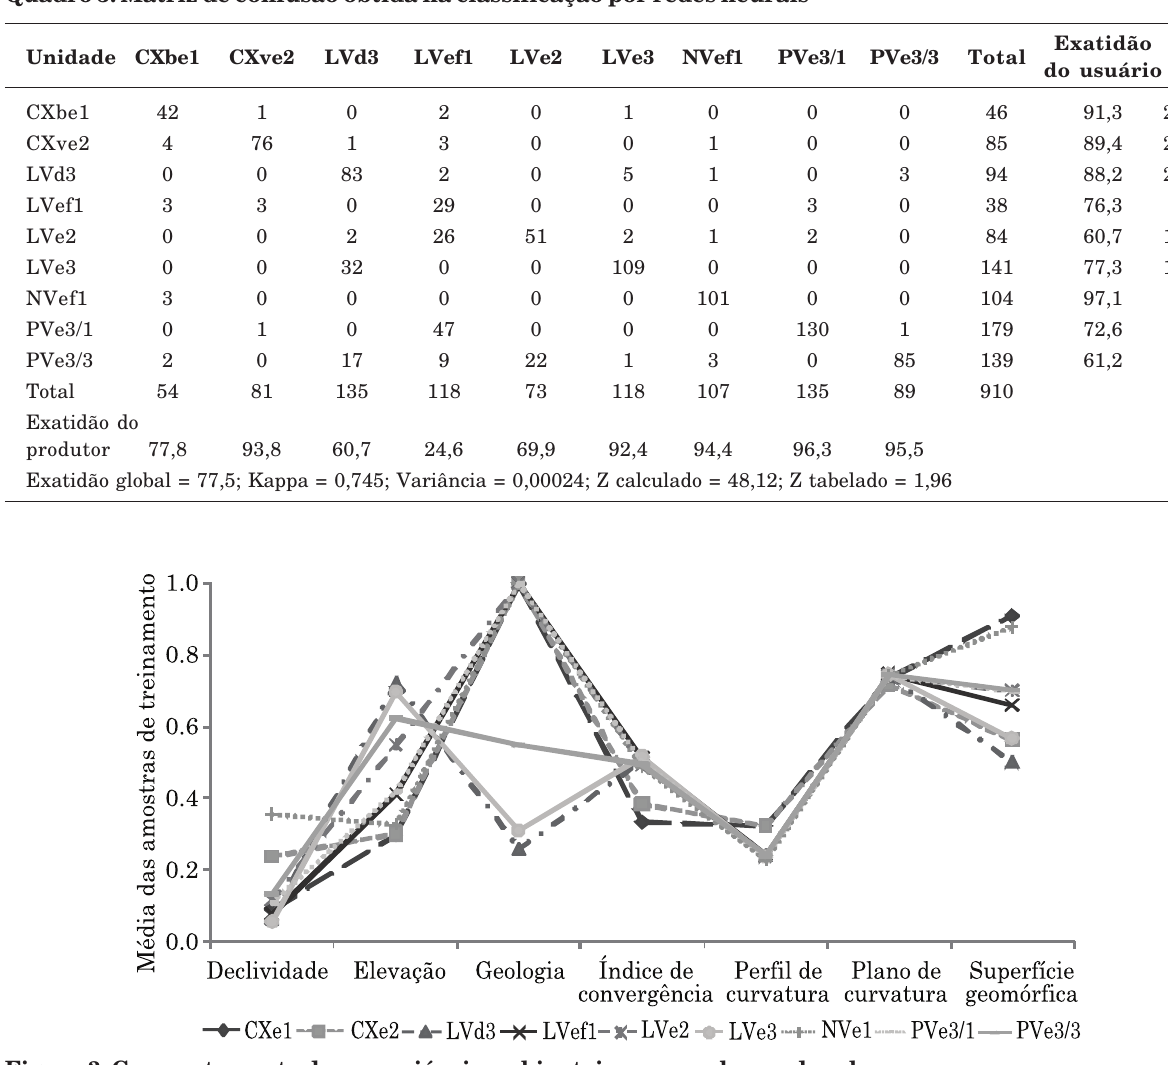
Figura 3. Comportamento das covariáveis ambientais para as classes de